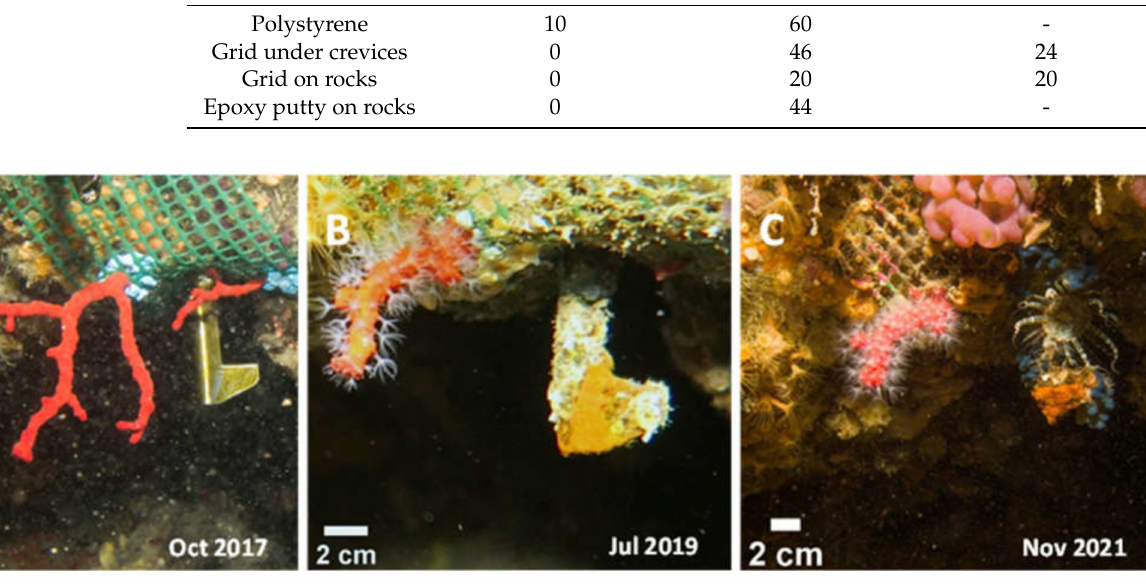
Figure 5. Corallium rubrum transplanted using the grid method under a crevice. The first day of the experiment with all their branches and initial sizes ( A ), one year after transplantation with lost branches and decreased size ( B ), and the last survey with one transplant covered by epibiosis ( C